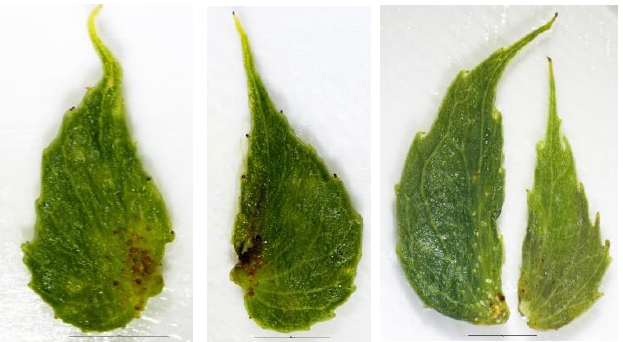
Figure 6. Stipules of S. babylonica var. matsudana ‘Umbraculifera’ ( left , center ) and S. babylonica ’Babylon’ ( right ).